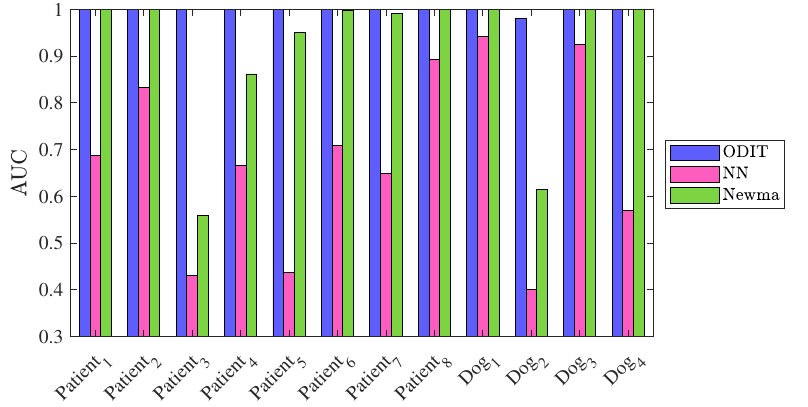
Figure 10. Performance comparison of the detectors in terms of the AUC of ROC curve for each